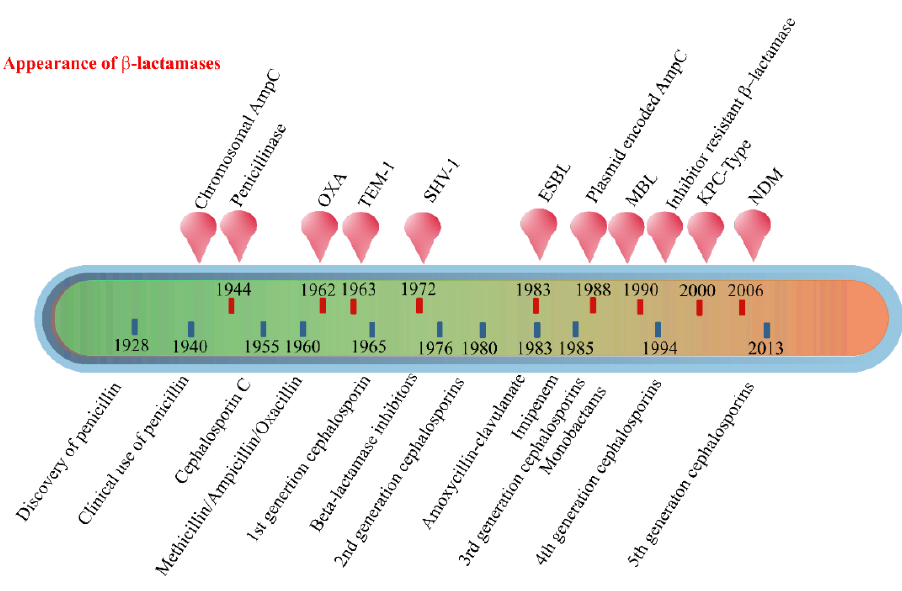
Figure 2. Evolution of β -lactamases. Within five decades of discovering the first penicillin-degrading enzyme, β -lactamases capable of hydrolyzing most β -lactam antibiotics, and resistance to inhibitors have emerged. The ability to tolerate a broad spectrum of β -lactams and inhibitor combinations is bolstered by the presence of multiple β -lactamase-encoding genes in a single pathogen.